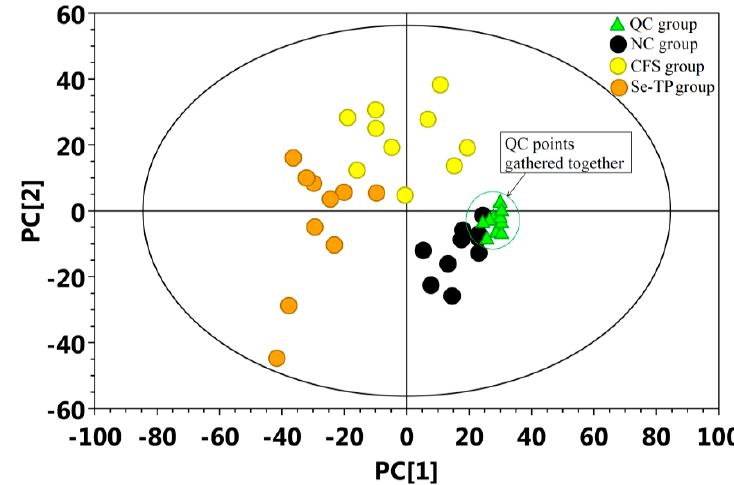
Figure 5. Evaluation of GC-MS detection model through the PCA scores plot of QC samples. Gathered points of QC sample showed that the PCA model was reliable.